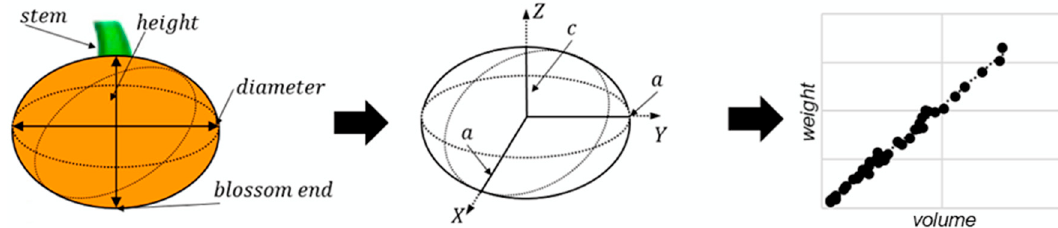
Figure 5. Two-dimensional representation of the pumpkin fruits and its extension in height and diameter (left), volume calculation using shape of spheroid (middle), and empirical linear regression for weight estimation of detected fruits from volume (right).